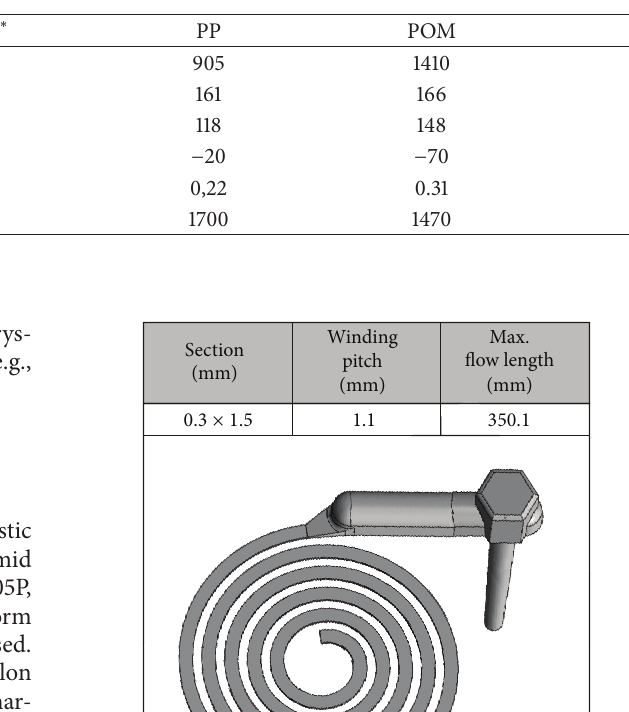
Table 1: Characteristics of the investigated materials (manufacturer’s data).